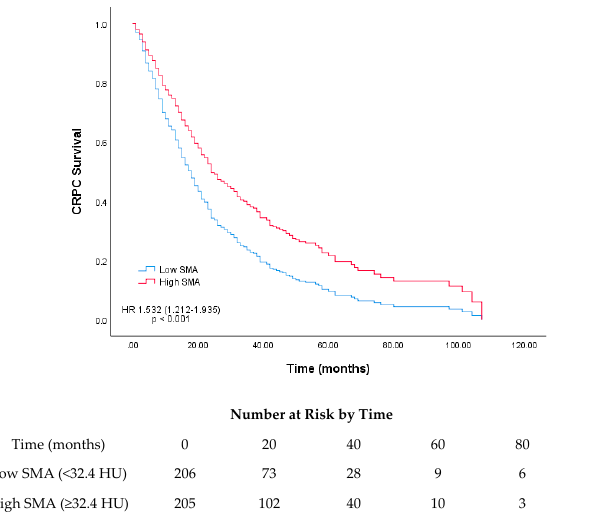
Figure 2. Survival curves based on Cox regression analysis of the survival of patients with castration- resistant prostate cancer (CRPC) stratified according to their median skeletal muscle attenuation (SMA; Hounsfield unit).